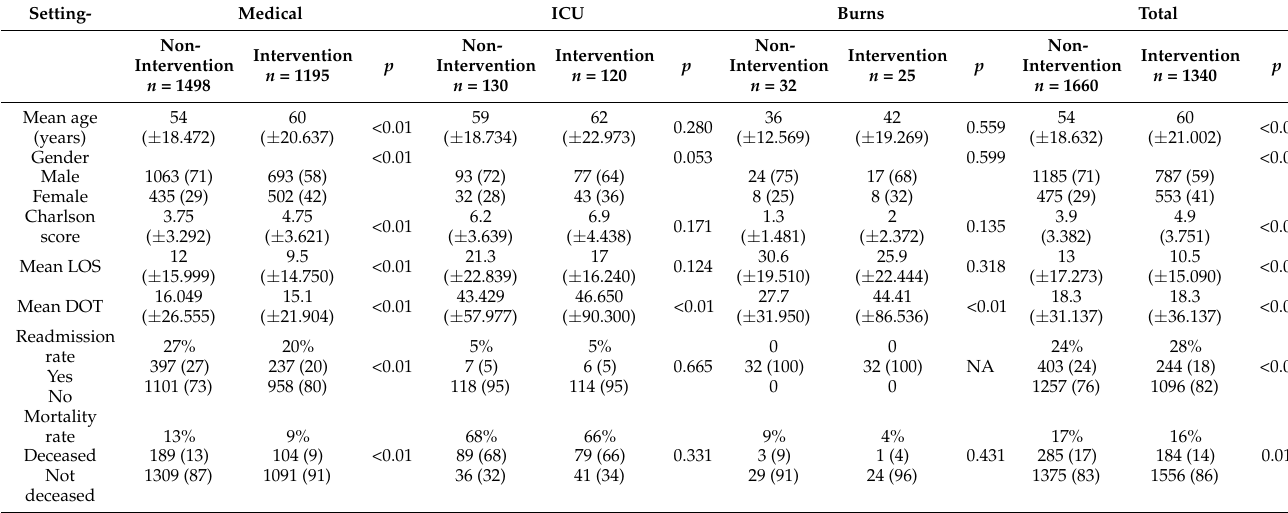
Figure 1. Flow chart of distribution patients included in the three clinical settings (medical, ICU, and burns unit). Table 1. Patients’ baseline characteristics and clinical outcomes comparison between non-intervention and ASP MDT intervention groups.